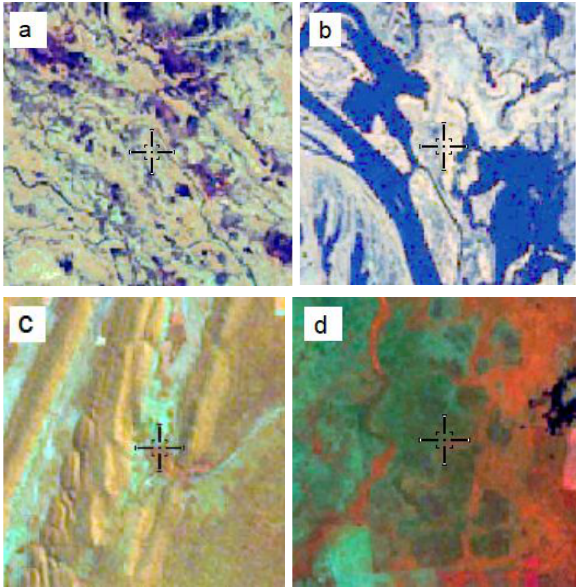
Figure 7a. Grassland Formation; Figure 7b. Wetland; Figure 7c. Forest Formation; Figure 7d. Savannah